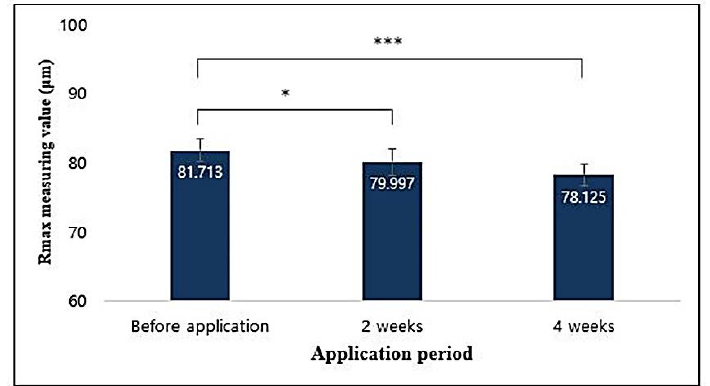
Figure 14. Correlation between application period of formulated cosmetics product and eye wrinkle roughness depth values (Rmax) analyzed using PRIMOS High Resolution. Data are given as mean ± SEM and statistical significance is shown by ANOVA (* p < 0.05; *** p < 0.001). Antioxidants 2020 , 9 , x FOR PEER REVIEW